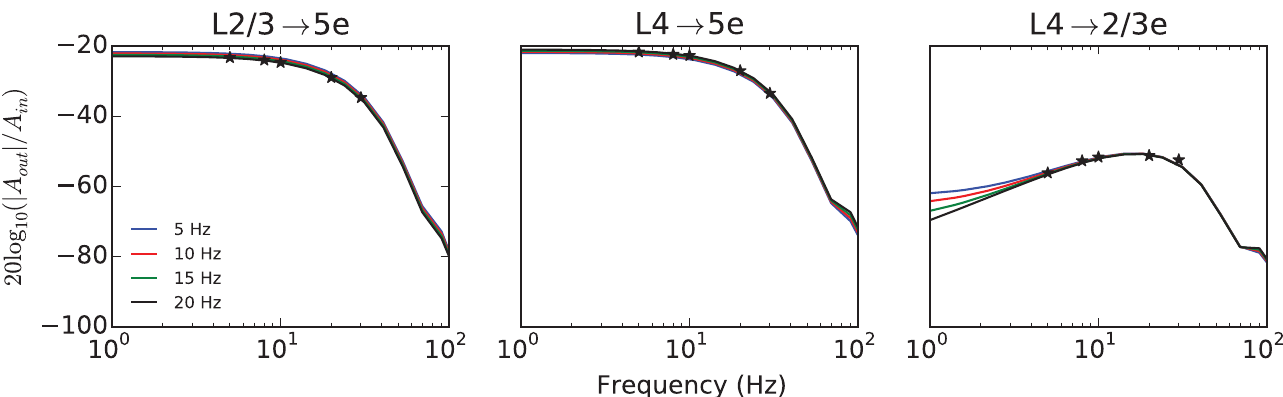
Fig 8. Amplitude attenuation of balanced sinusoidal drive. This figure summarizes the amplitude attenuation of 3 example transformations. Sinusoidal input with amplitude A in drives superficial layers (L2/3 or L4), and expresses output in the L5e or L2/3e subpopulation with an attenuated amplitude A out . These filters are numerically computed at 4 different input amplitude strengths, and then normalized, further demonstrating linearity. The output from L5e (left and middle column) is lowpass filtered with a cutoff frequency near 15 Hz, corresponding to an RC circuit with a time constant near the membrane time constant (10 ms) of neurons in the system. The response of L2/3e in response to L4 drive is bandpass in the 10 – 30 Hz range. The averaged power spectral densities of 100 matched NEST simulations run at driving frequencies 5,8,10,20, and 30 Hz (20 Hz input amplitude) are plotted for